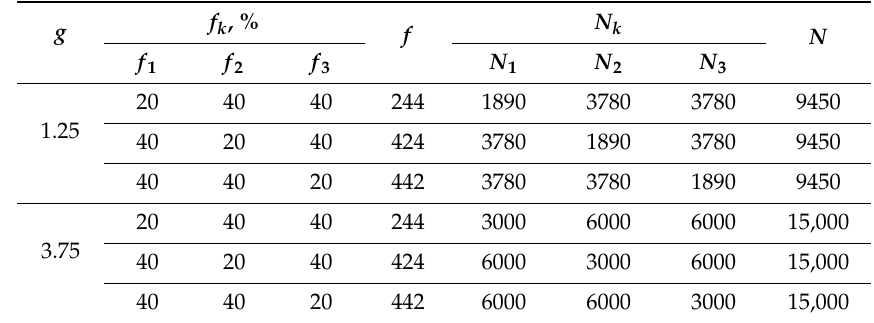
Table 3. Values of f k along with N k and N in mixtures with g = 1.25 and 3.75 and PSD nonuniform by number of